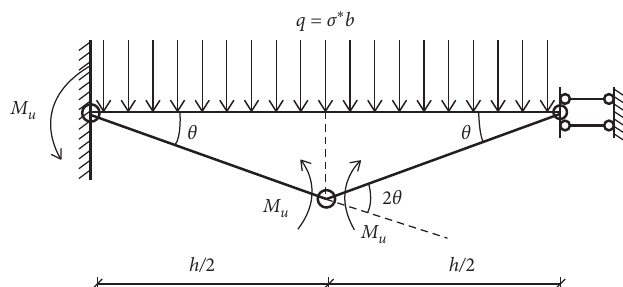
Figure 8: Calculation model for the ultimate load of CFST pile.